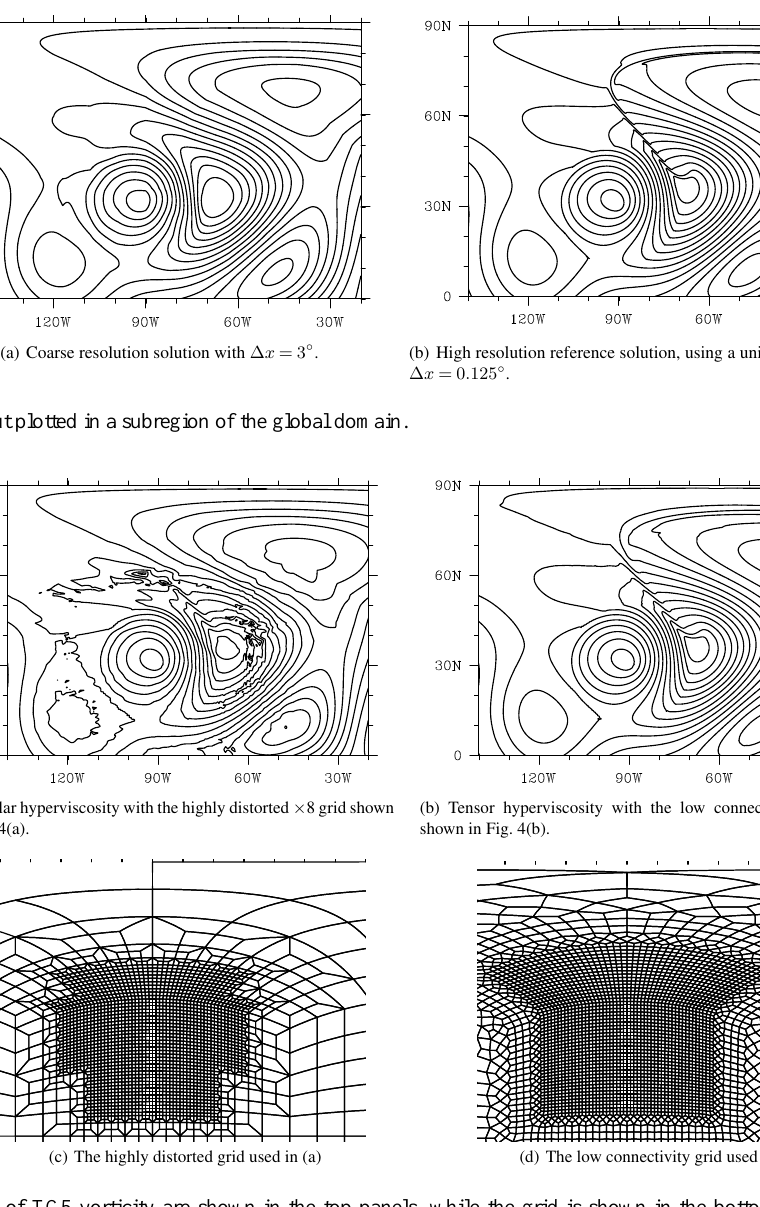
Figure 9. Contour plots of TC5 vorticity are shown in the top panels, while the grid is shown in the bottom panel. The contour interval is 5 . 0 × 10 − 6 s − 1 . All panels show a subregion of the global domain, which contains most of the refined region and is identical to the subregion used in Fig. 8. Panel (a) shows results using scalar hyperviscosity on the highly distorted grid shown in (c) . Panel (b) shows results using tensor hyperviscosity on the low-connectivity grid shown in (d) . The improved hyperviscosity and mesh quality result in significantly improved